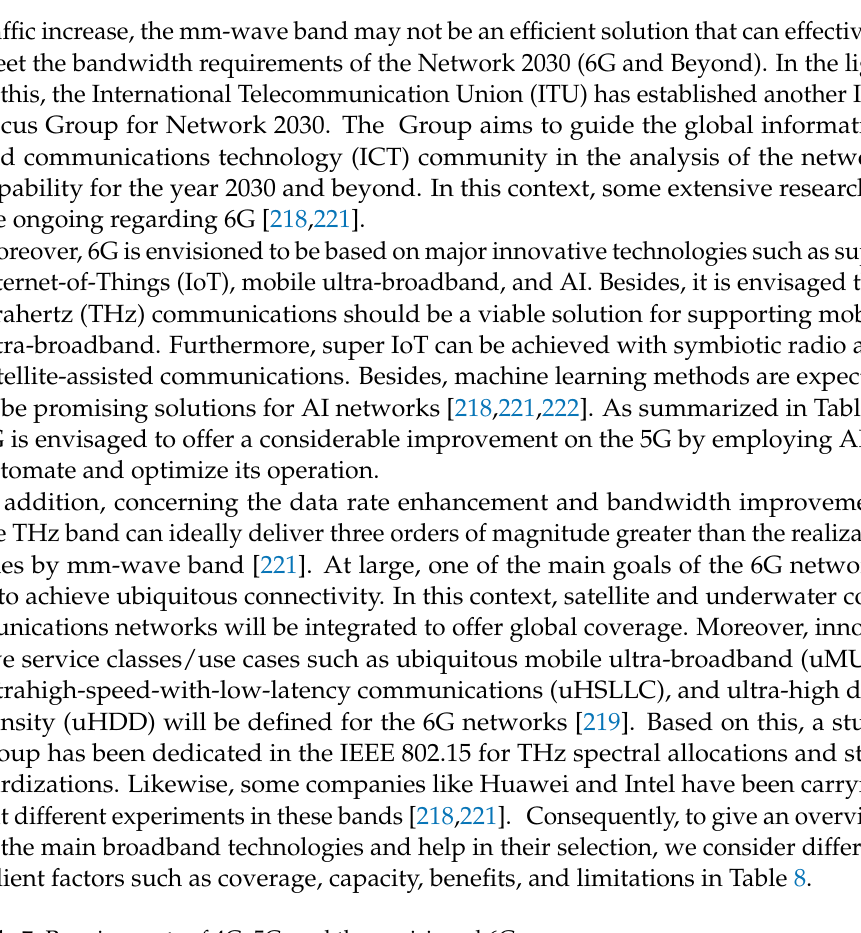
Table 7. Requirements of 4G, 5G, and the envisioned